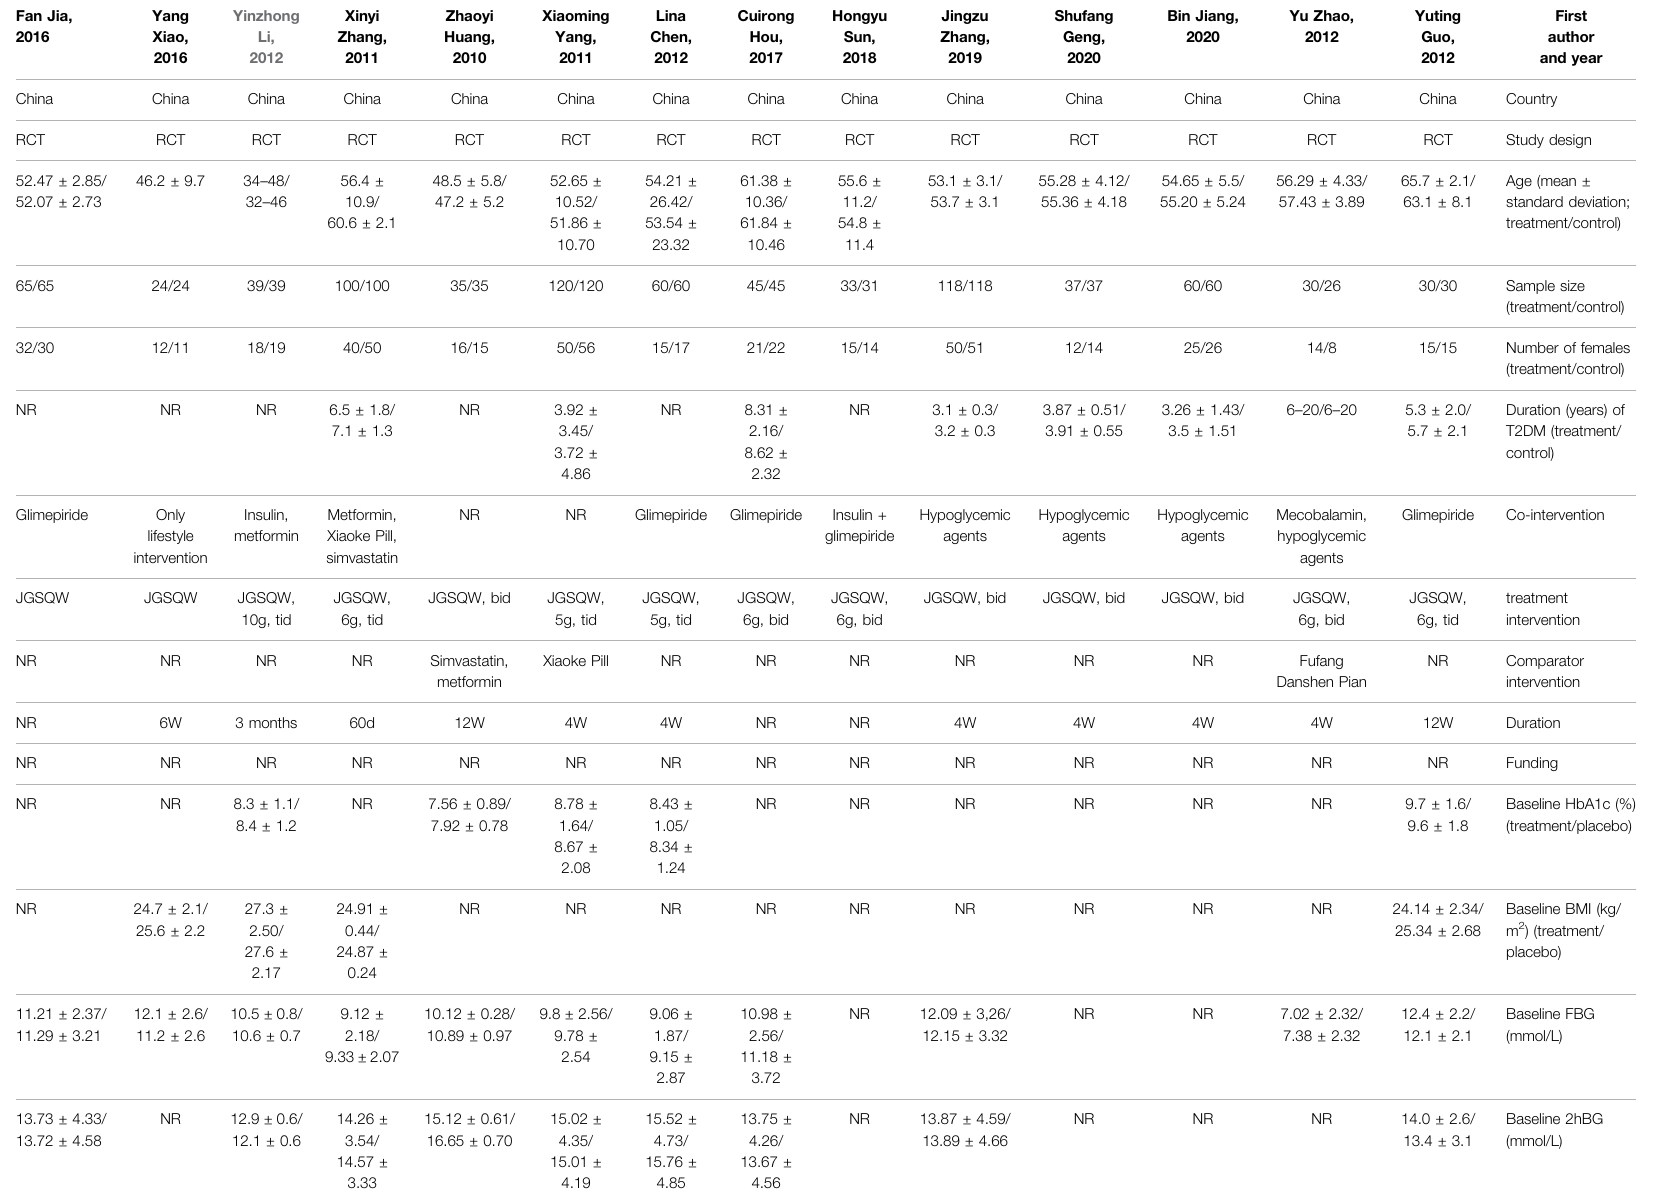
TABLE 2 | Characteristics of the included studies. Fan Jia,